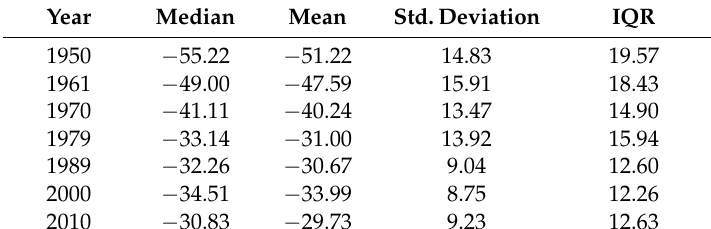
Table 4. Relative error (%) of the results for all municipalities (n = 107). Table 4 Relative error (%) of the results for all municipalities (n=107).